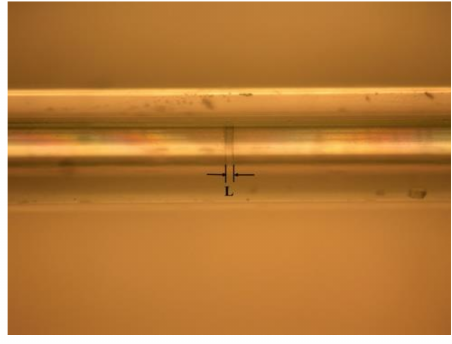
Figure 4. Photo of a fiber FP sensor.